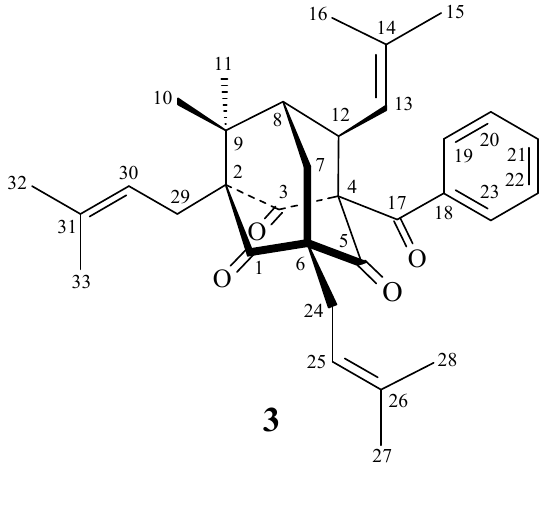
Figure 2. The chemical structure of known compound 3 isolated from H. sampsonii